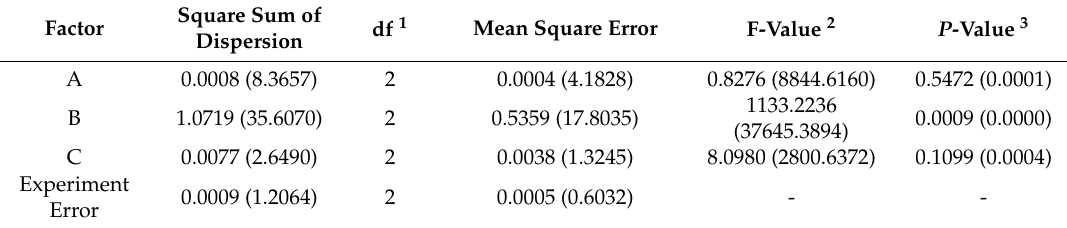
Table 4. ANOVA analysis results of Sa and Sz.